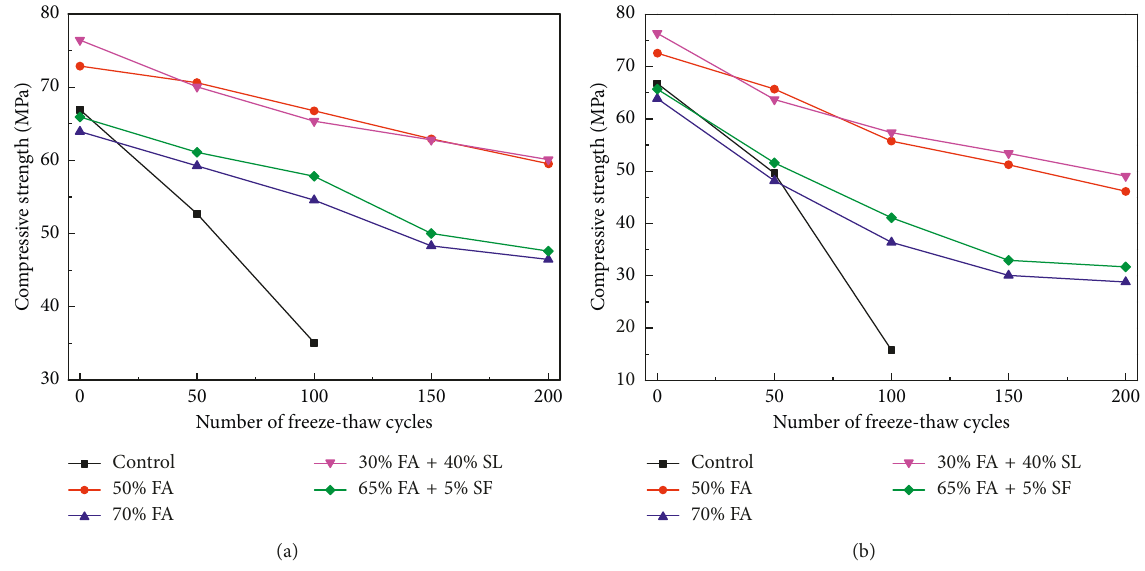
Figure 4: Compressive strength under freeze-thaw cycles: (a) in tap water and (b) in sodium chloride solution.